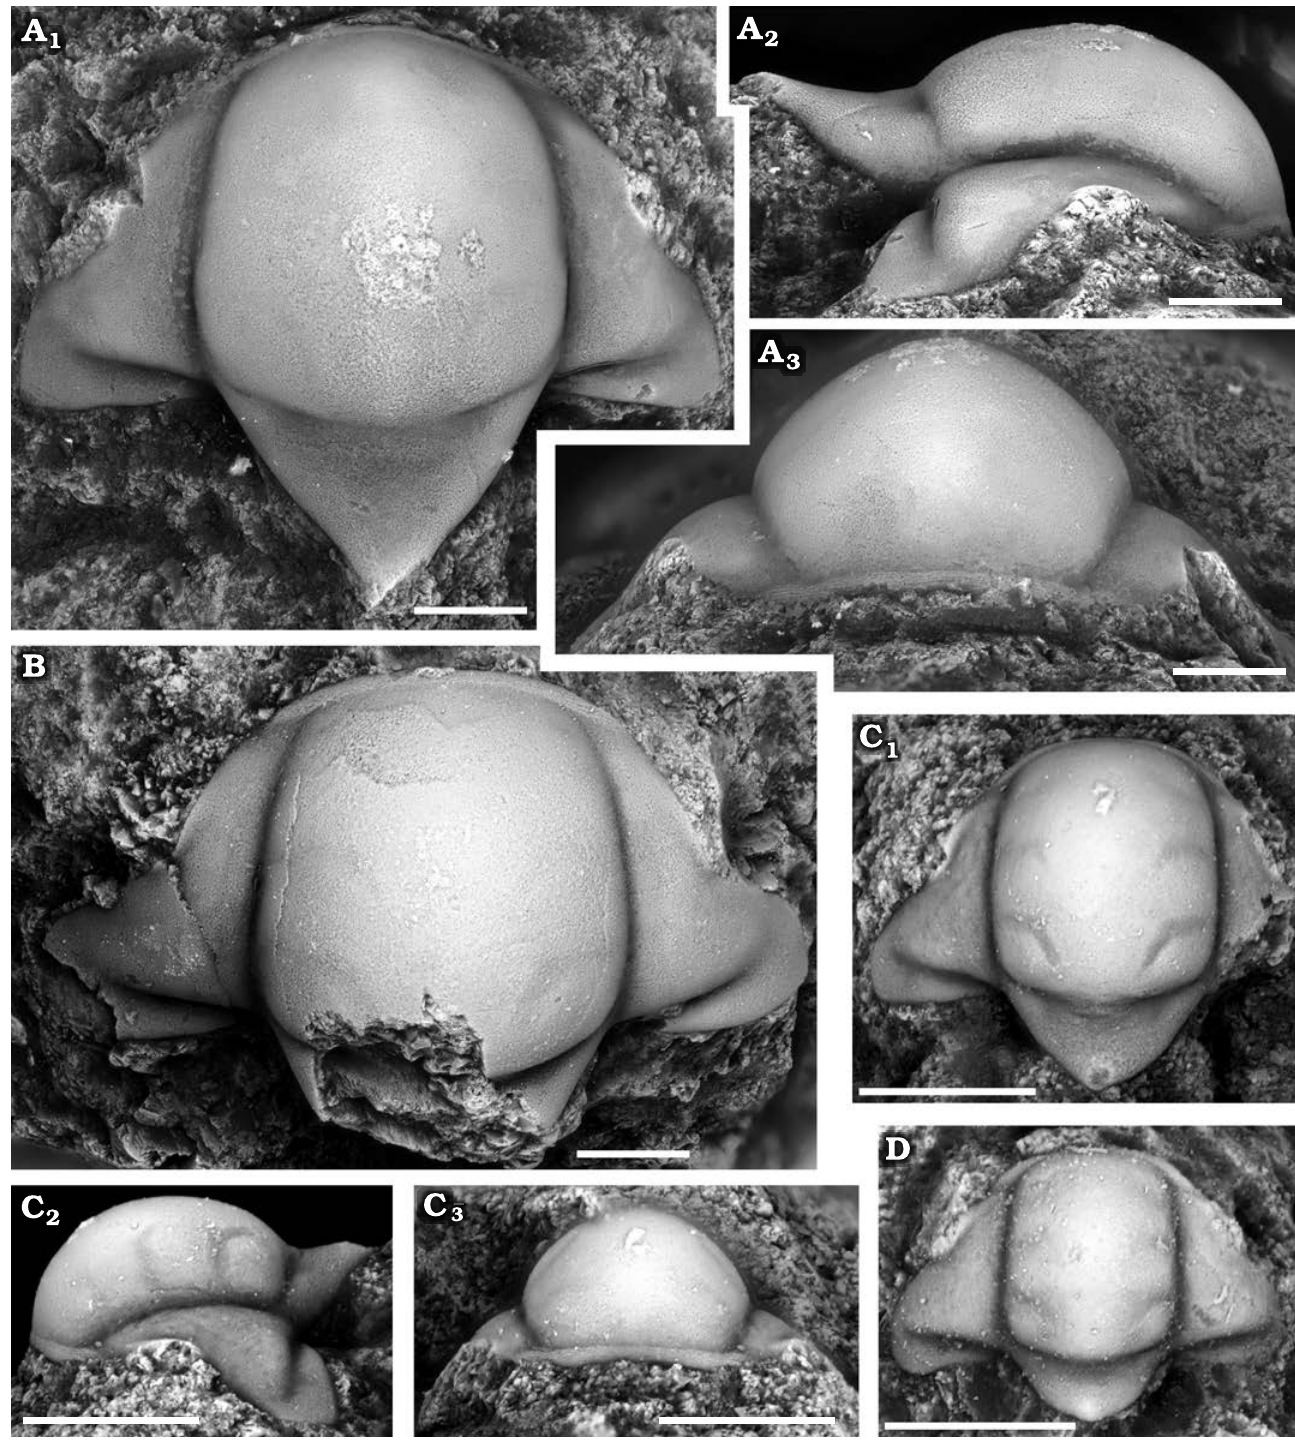
Fig 1. Cranidia of catillicephalid trilobite Catillicephala cifellii sp. nov. from the Downes Point Member, Shallow Bay Formation, Guzhangian, Miaolingian, Cambrian; boulder BPS 467, Broom Point South, western Newfoundland, Canada. A . GSC 142512, holotype; dorsal (A 1 ), lateral (A 2 ), and anterior (A 3 ) views. B . GSC 142513, paratype; dorsal view. C . GSC 142514, paratype; dorsal (C 1 ), lateral (C 2 ), and anterior (C 3 ) views. D . GSC 142515, paratype; dorsal view. Scale bars 1